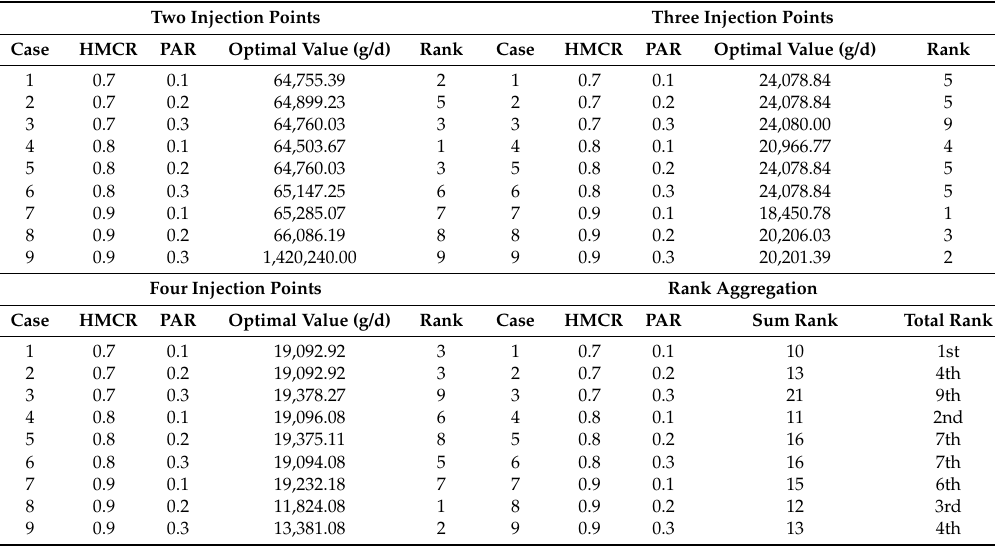
Table 2. Optimal results for various parameter